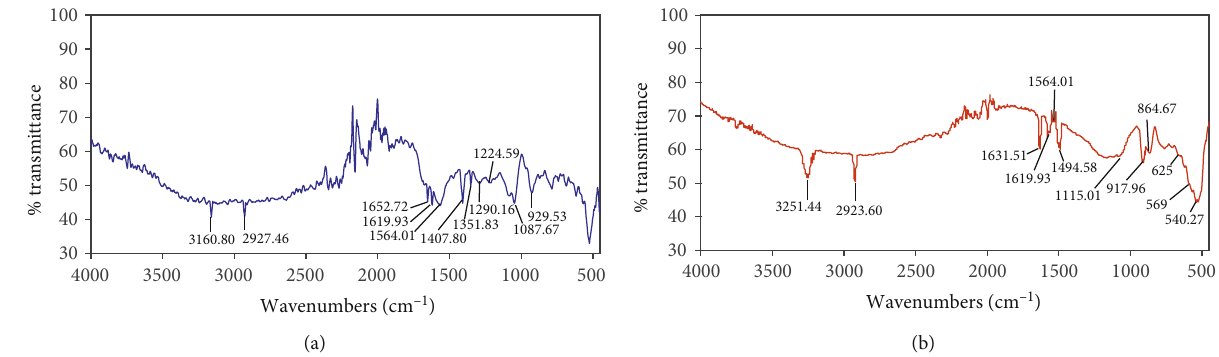
Figure 6: The FT-IR results related to PPy-Chi-CaFe